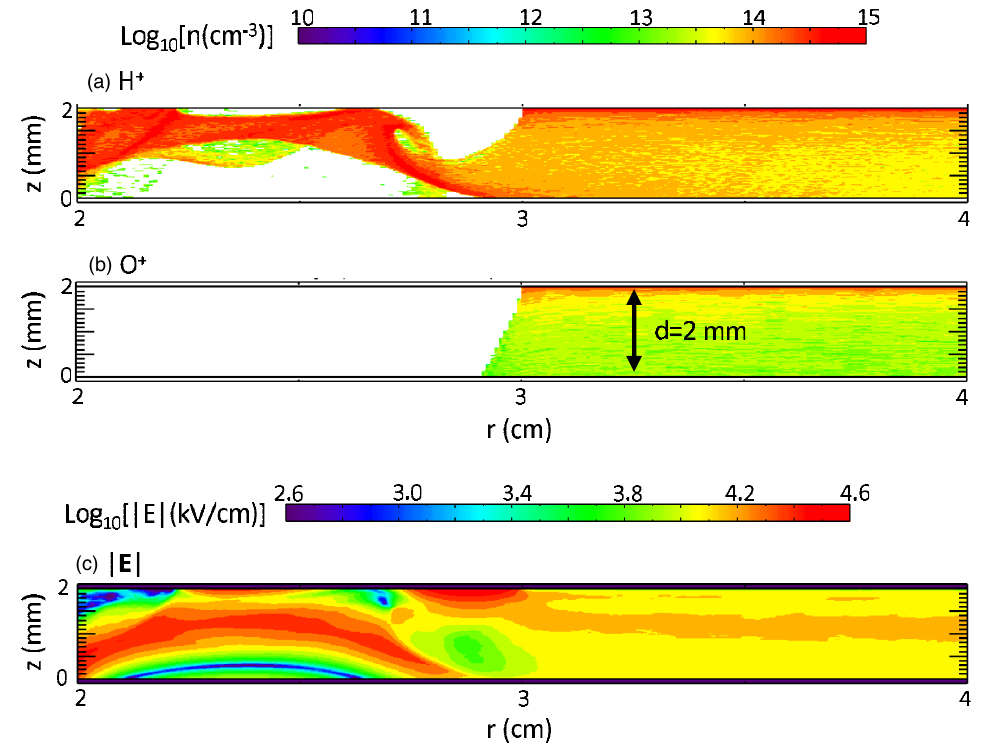
FIG. 7. Snap shots of (a) the H þ number density, (b) the O þ number density, and (c) the electric field magnitude for the immobile electron, two-ion-species case with a 3-mm AK